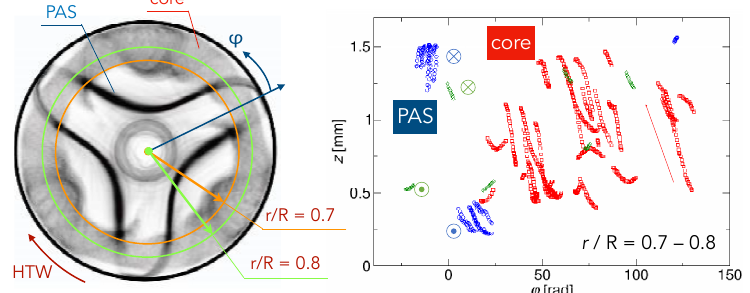
Figure 10. ( left ) Coherent structure under the same condition as shown in Figure 9, and ( right ) spatial distributions of paths in the z – φ space in 0.7 ≤ r / R < 0.8. In the right frame, the particles attracted to T 3 , T core and T 9 are drawn in blue, red and green, respectively. The arrow indicates 3 3 the direction of motion of the particles concerned. The direction in r of the particle motions is also indicated; (cid:12) indicates the motion toward the free surface (or in positive r direction), and ⊗ that toward the centre axis of the liquid bridge (or in negative r